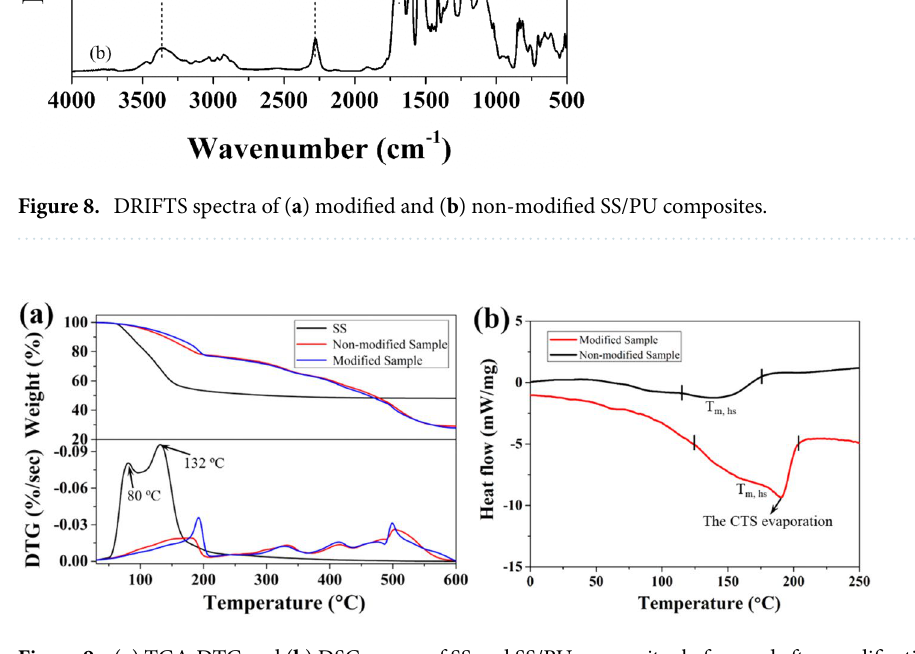
Figure 9. ( a ) TGA-DTG and ( b ) DSC curves of SS and SS/PU composites before and after